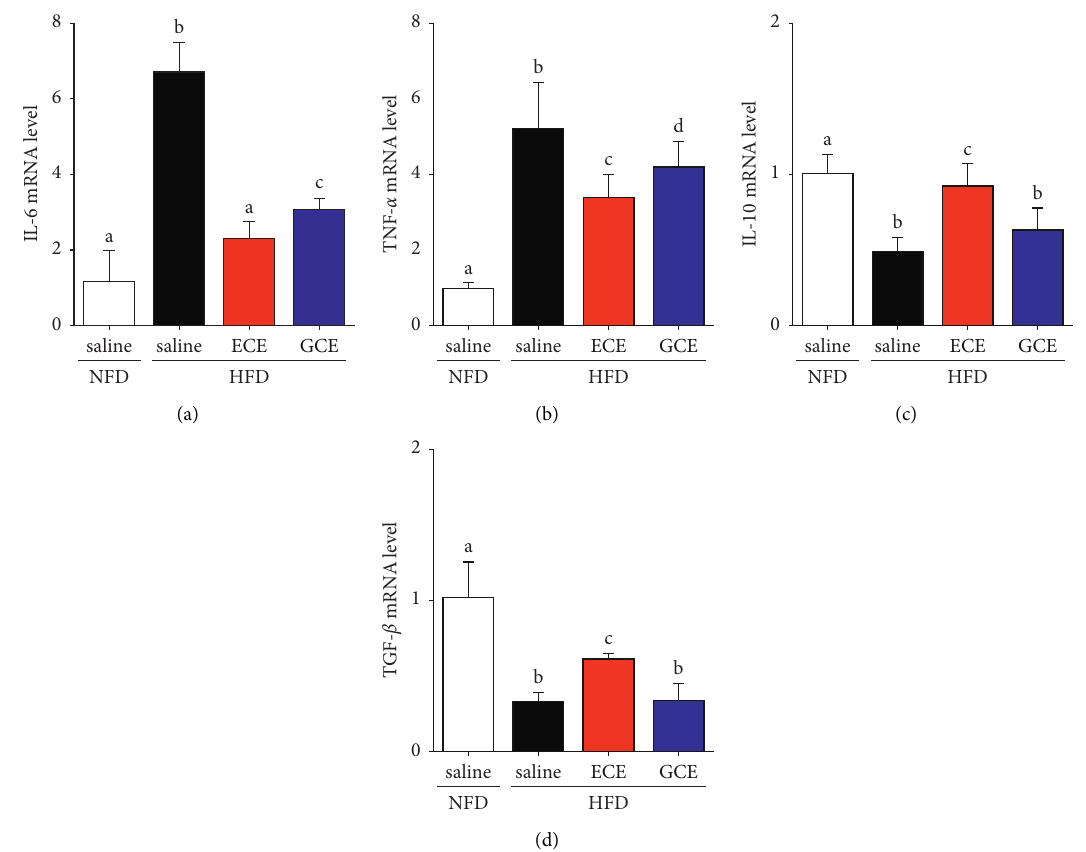
Figure 3: Effects of E . cava extract on inflammatory cytokines expression in visceral fat on high-fat diet- (HFD-) induced obese mice. (a, b) IL-6 and TNF- α as M1 macrophage-related inflammatory cytokines and (c, d) IL-10 and TGF- ß as M2 macrophage-related cytokines in visceral fat of standard normal fat diet with 0.9% saline (NFD/saline; open bar), HFD with 0.9% saline (HFD/saline; black bar), HFD with E . cava extract (HFD/ECE; red bar), and HFD with Garcinia cambogia extract (HFD/GCE; blue bar) group. All expression levels were determined by qRT-PCR, and all mRNA levels expressed relative level and normalized ß -actin of the NFD/saline group. The same letters represent no significant difference ( p < 0 .